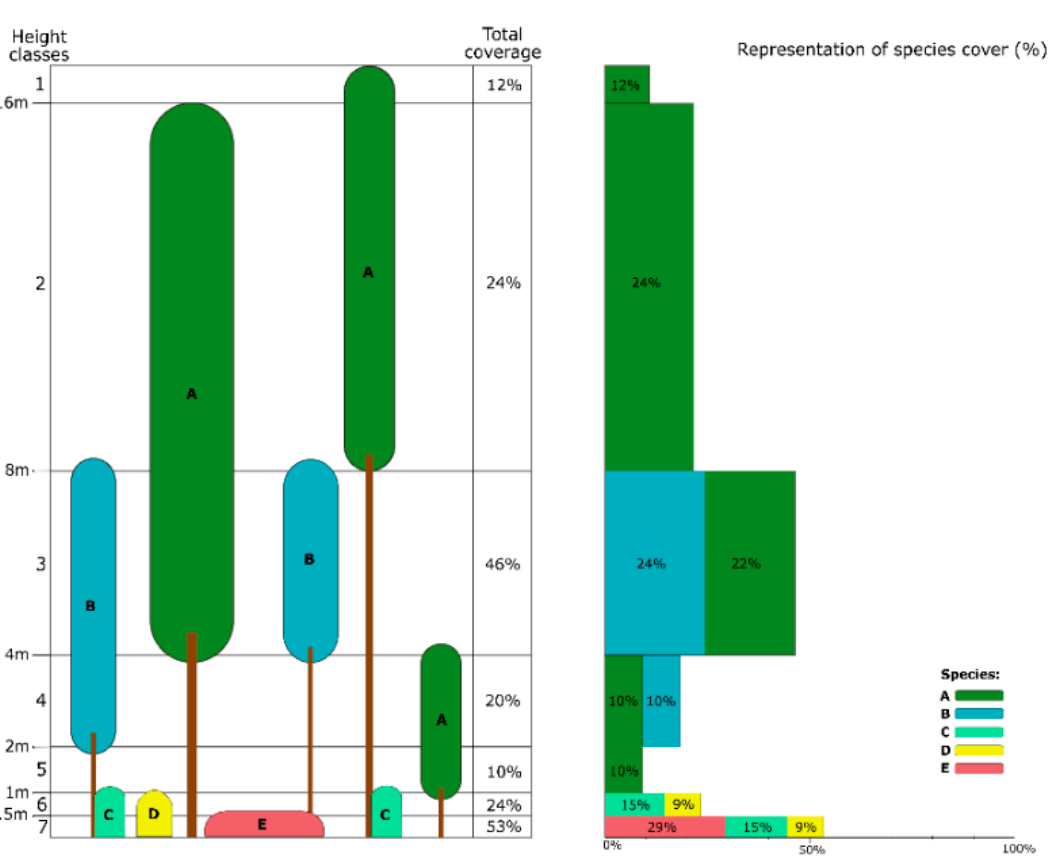
Figure 1. Example of vertical structure characterization with indication of percent coverage corresponding to each height classes (adapted from [34]).